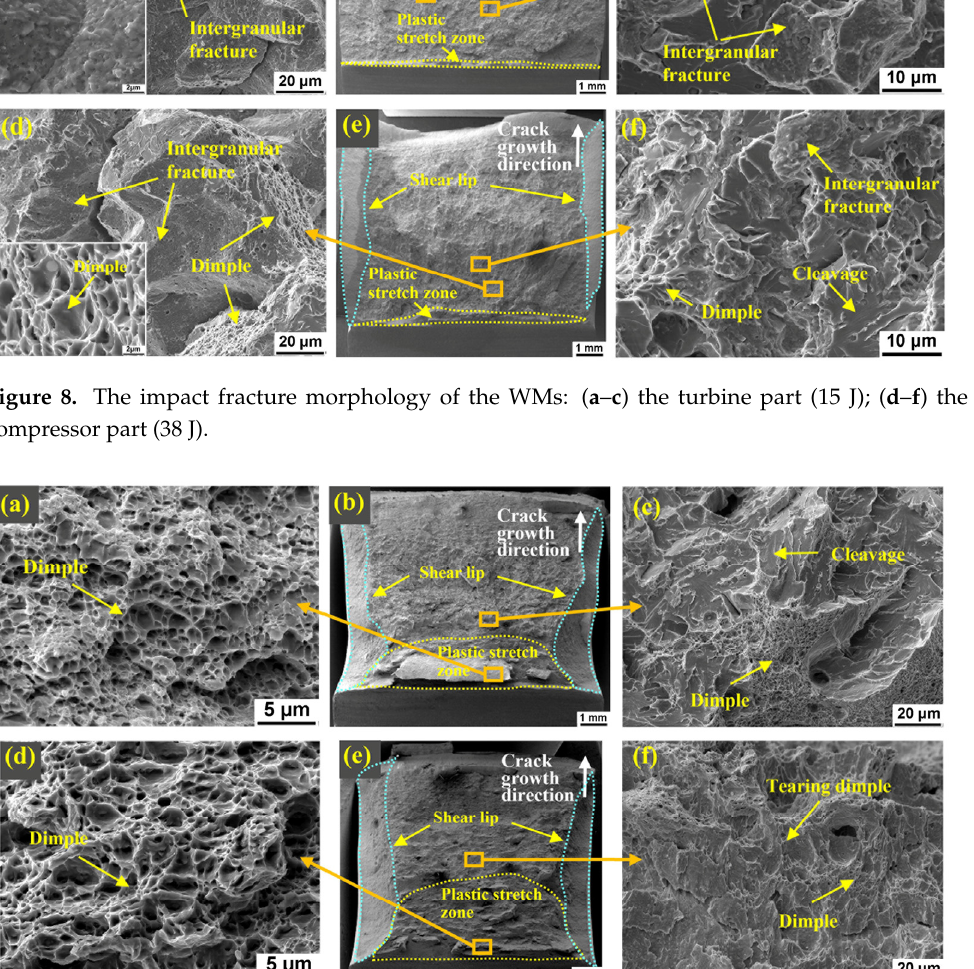
Figure 8. The impact fracture morphology of the WMs: ( a – c ) the turbine part (15 J); ( d – f ) the com- pressor part (38 J).